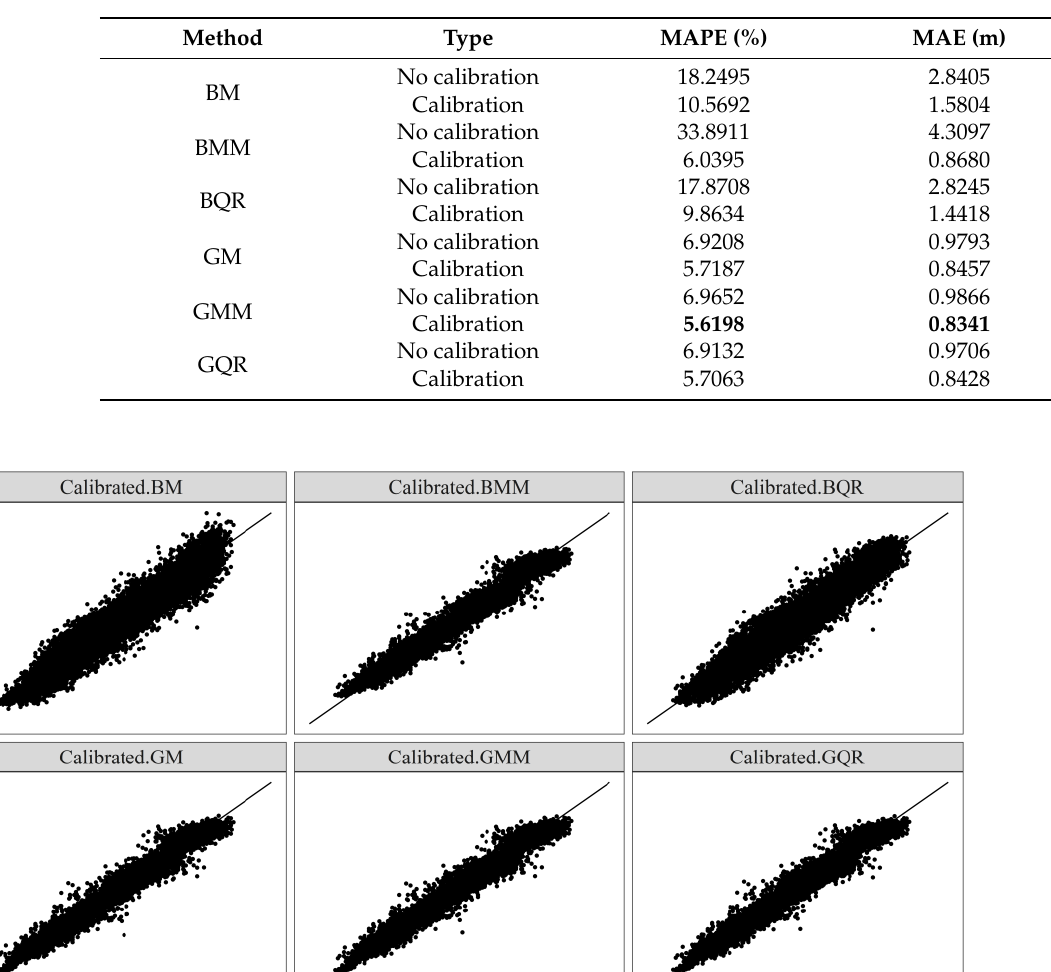
Table 5. Model evaluation statistics under uncalibrated or calibrated conditions with the BM, BMM, BQR model, GM, GMM, and GQR model, based on the jackknife technique. Bold numbers indicate the best model.